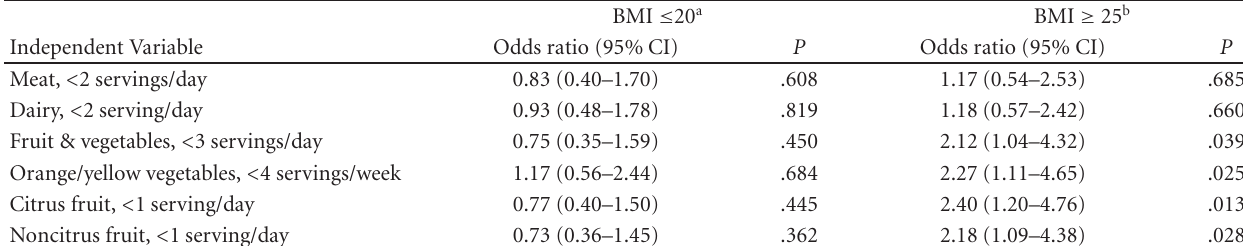
Table 3: Associations of dietary intake patterns with underweight or overweight/obesity in Georgia